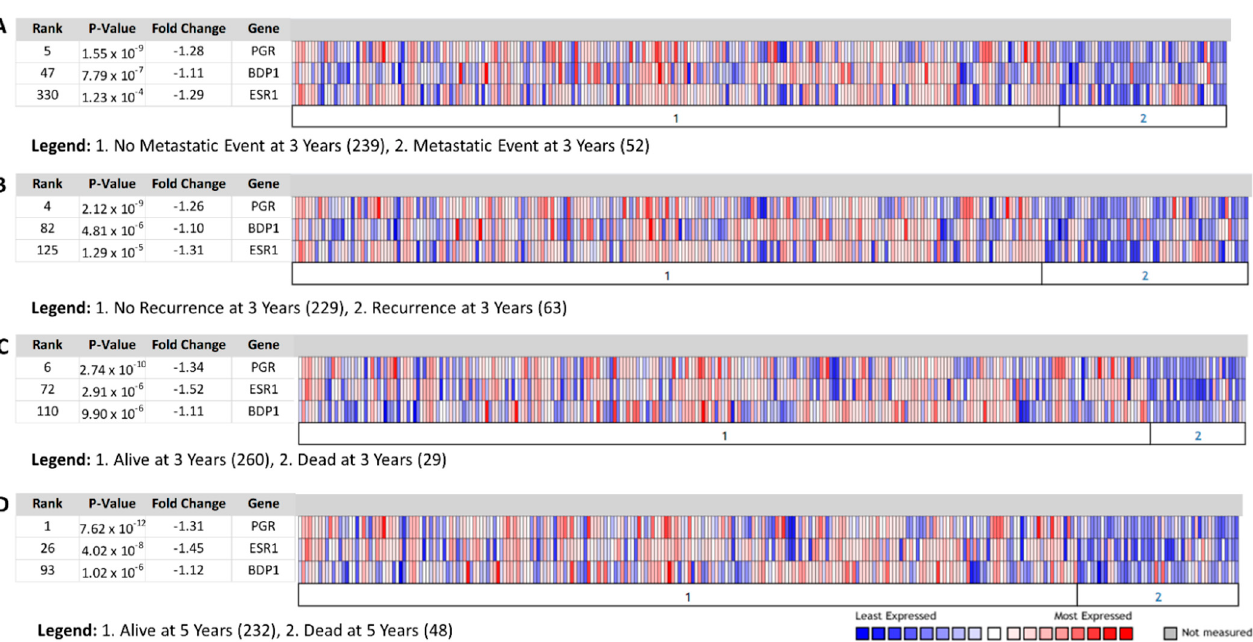
Figure 4. BDP1, progesterone receptor (PR), and estrogen receptor (ESR1) expression correlated with clinical outcomes. We queried the vandeVijver breast dataset [48], n = 295 samples, for changes in BDP1 and key breast cancer biomarkers (PR and ESR1) expression and clinical outcomes: ( A ) metastatic event at three years, ( B ) recurrence at three years, death at three ( C ) and five ( D ) years. [40]. Fold-change, p -value, and gene rank of 14,719 measured genes in IBC are denoted. The Oncomine™ Platform (Thermo Fisher, Ann Arbor, MI, USA) was used for analysis and visualization.